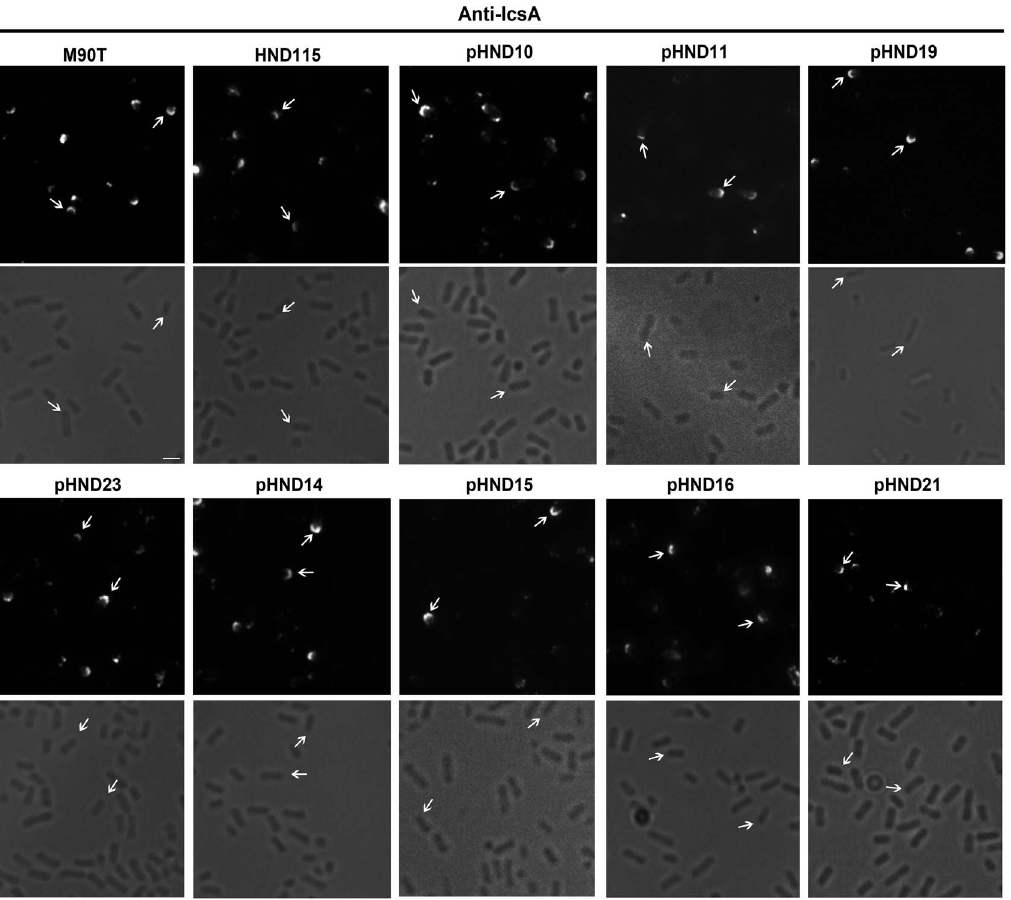
Figure 5. The 43 PPPP 46 motif is required for proper IcsA exposition. Bright fields and fluorescence microscopy of IcsA of the wild-type strain M90T, HND115 and HND115 complemented with recombinant plasmids pHND10, 11, 19, 23, 14, 15, 16 and 21 (indicated at the top). 0.016% of L- arabinose was used to induce phoN2 ::HA expression. IcsA was detected in exponentially-growing bacteria, fixed with paraformaldehyde and labelled with anti-IcsA rabbit polyclonal antibody. Subpopulations of IcsA-labelled bacteria are shown. Arrows, polar foci of IcsA. Experiments were repeated at least three times and typical results are shown. Bar =2 m m.